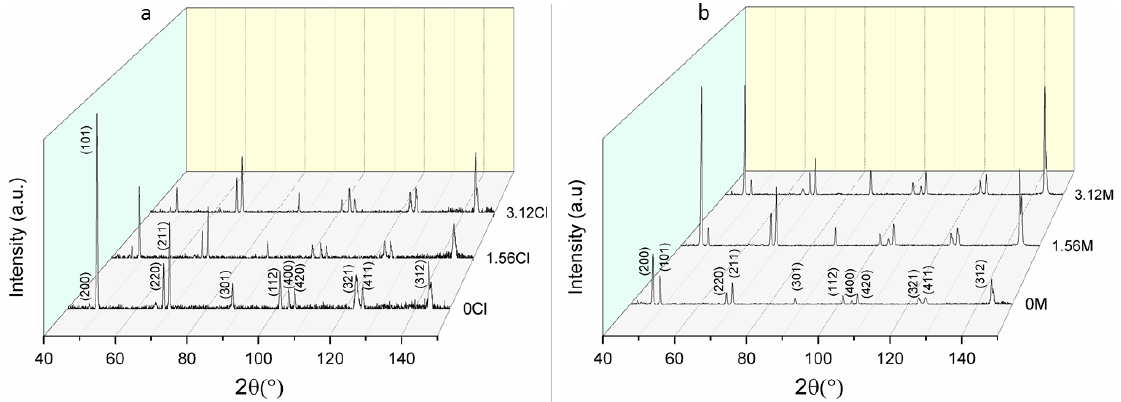
Figure 11. ( a ) 3D X-ray diffraction profile of the Sn samples deposited from stationary chloride electrolyte with increasing ABN concentration ( b ) and of the Sn samples deposited from non-stirred MSA electrolyte.